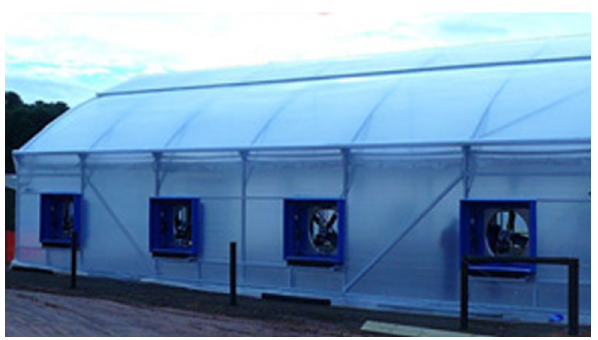
Figure 8: Polyethylene sheet covering